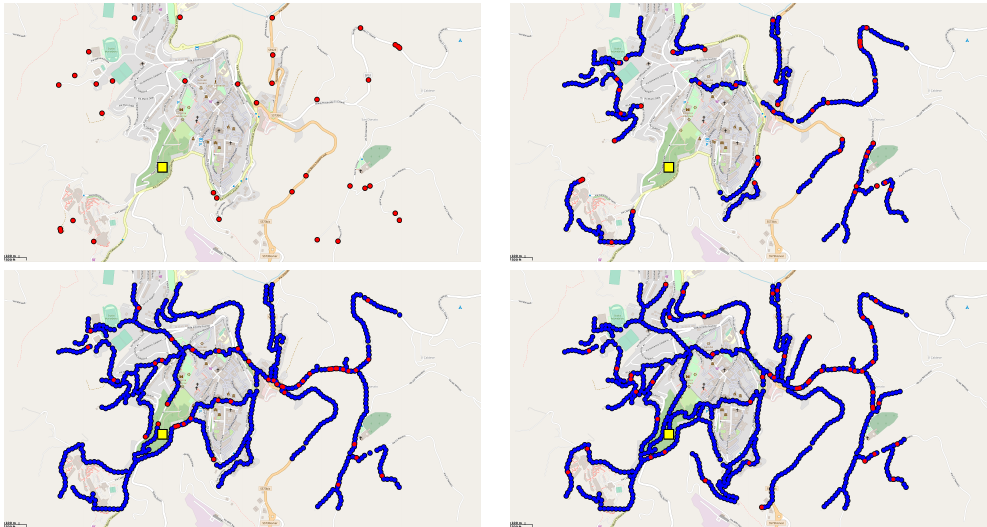
Figure 5. Snapshot of the simulation. Initially, ( top left ) explorers (red dots) are deployed in random positions in the simulation arena. A PoI (yellow square) is generated randomly as a reference point for route computation. When the simulation begins ( top right ), explorers begin wandering the map along the available routes, and when conditions are appropriate, they spawn virtual devices (blue dots). With time, explorers indirectly increase the knowledge of the actual road structure ( bottom